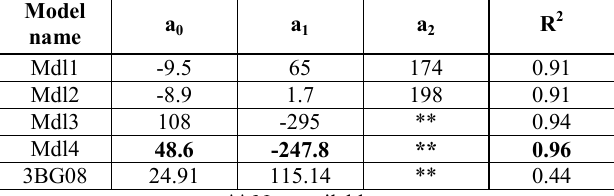
Table 3 . Coefficients derived from calibration using OLS